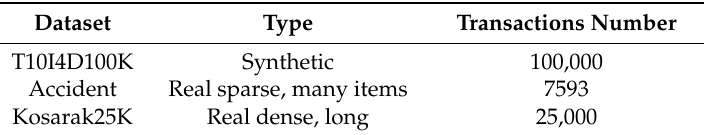
Table 4. Dataset